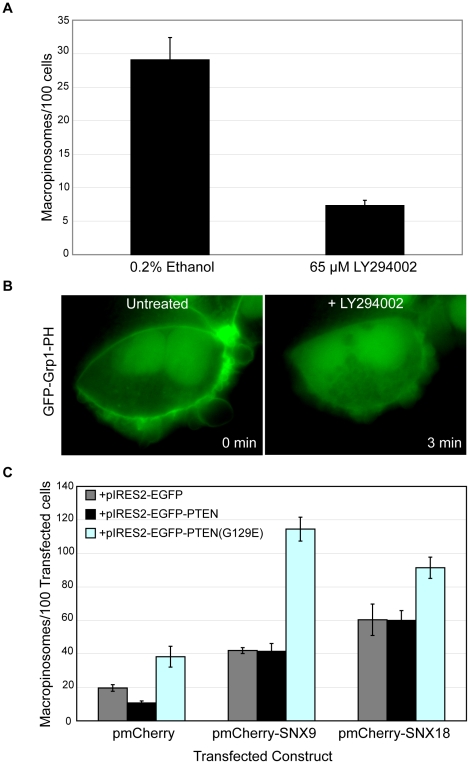
The modulation of PI(3,4,5)P3 levels affects macropinosome formation.A: HEK-Flp-In cell monolayers were treated with either 65 µM LY294002 or carrier (0.2% Ethanol) for 30 minutes at 37°C prior to pulsing with dextran-TR as described in Materials and Methods in the continued presence of the drug or carrier. The mean number of macropinosomes/100 cells was quantitated as described in Materials and Methods. Error bars represent S.E.M. B: HEK-Flp-In cell monolayers transfected with pEGFP-Grp1-PH for 24 hours were imaged using the 100× oil immersion objective of an Olympus IX-81 OBS Real Time microscope before and after treatment with 65 µM LY294002. Time following LY294002 treatment is indicated in bottom right hand corner of each panel. C: HEK-Flp-In cells transiently transfected with pIRES2-EGFP, pIRES2-EGFP-PTEN, or pIRES-EGFP-PTEN(G129E) were co-transfected with pmCherry, pmCherry-SNX9, or pmCherry-SNX18 and assayed for macropinosome formation as described in Materials and Methods. The mean number of macropinosomes/100 transfected cells was quantitated over 3 replicates of 500 transfected cells for each condition. Error bars denote S.E.M.